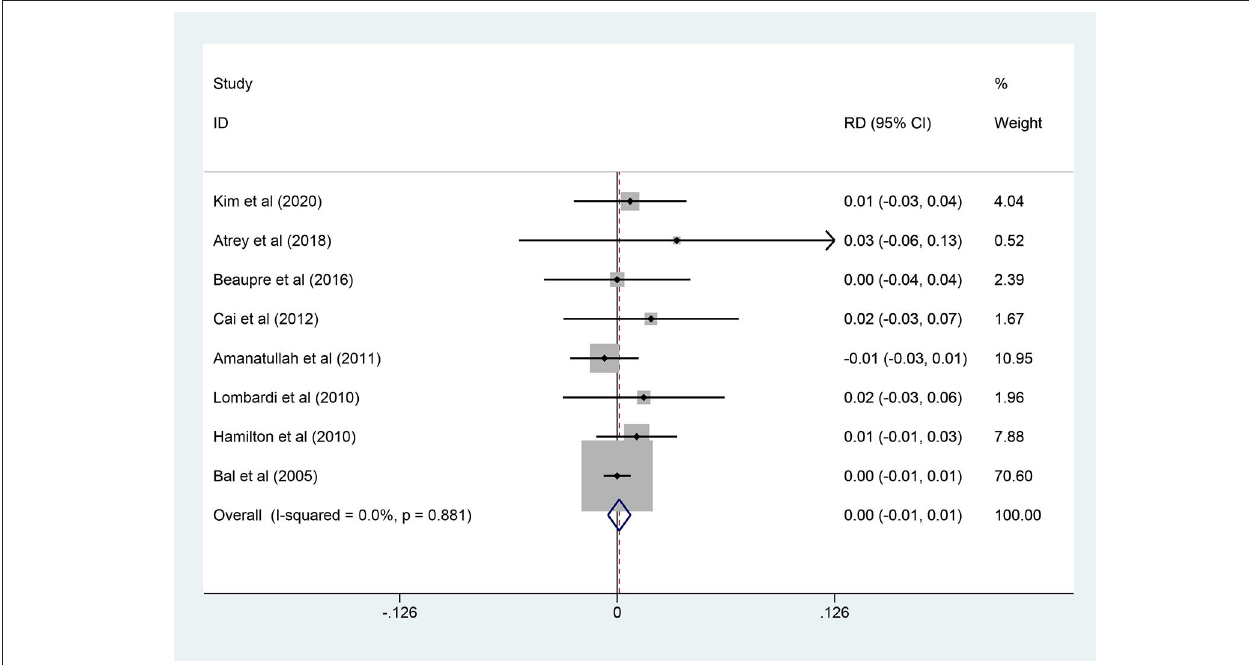
FIGURE 6 | Forest plot diagram of the overall deep infection rate of the replaced hip with COC and COP bearing surfaces.